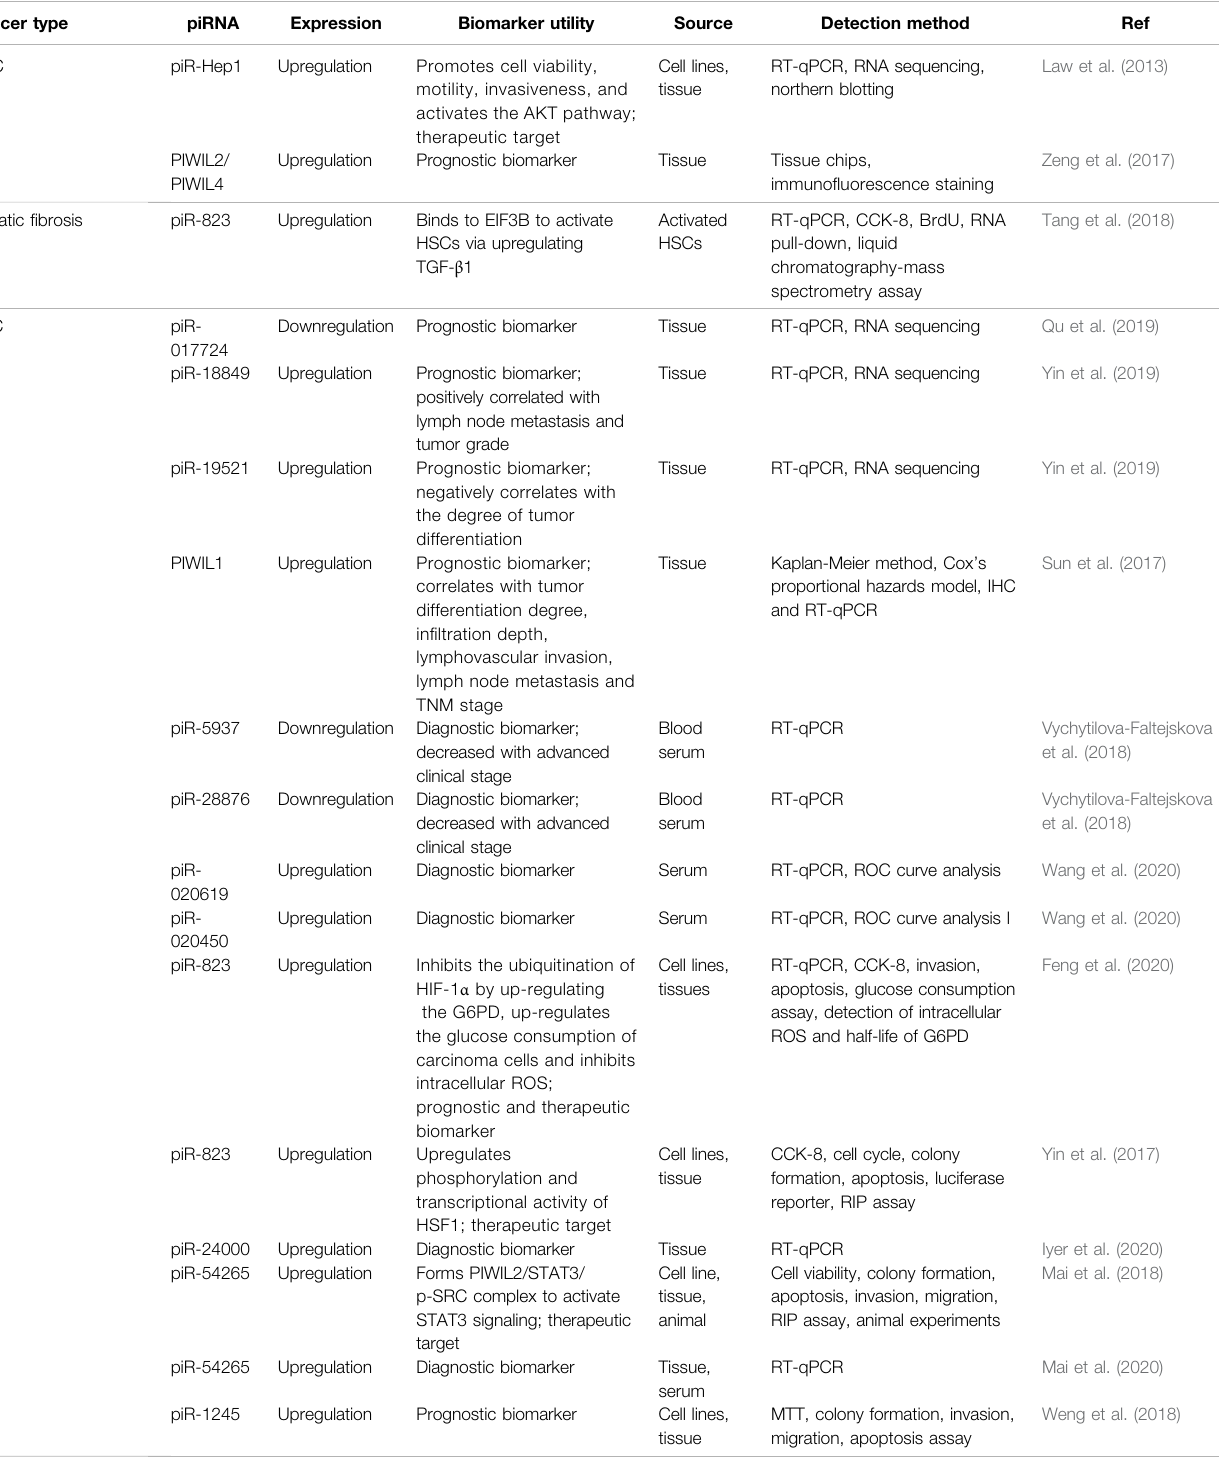
TABLE 1 | Summary of piRNAs and PIWI proteins in digestive system